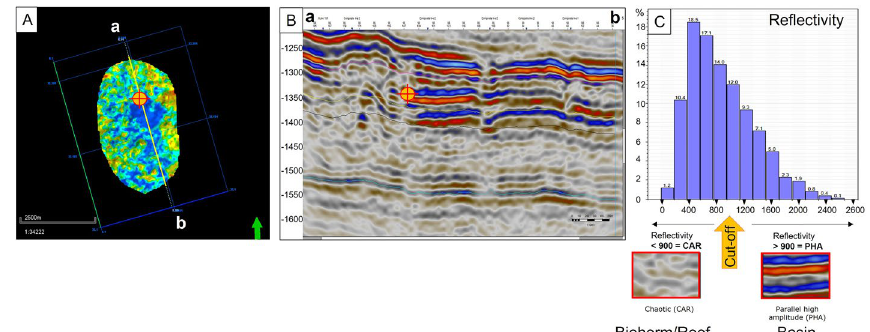
Fig. 12 Cut-off definition via cursor-tracking mode and visual comparison. A adjusted attribute map compared simultaneously with the seismic line ( B) to define the threshold for basin and reef/bioherm and basin ( C) . This visual and iterative approach is used to define the cut-off value and works best at the onlaps of the parallel high-amplitude seismic facies with the chaotic facies. It needs to be adjusted for each time slice using multiple inlines and crosslines. The upscaled image facies interpretation from the 2 geothermal wells supports the correlation of the seismic facies with the deposition environment (basin facies or bioherm/reef